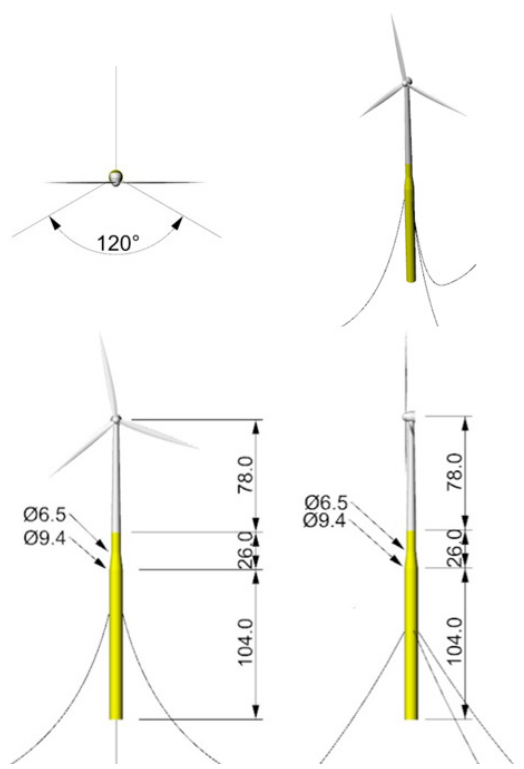
Figure 1. The schematic diagrams of the NREL 5MW wind turbine mounted on the OC3-Hywind or UMaine-Hywind spar with the catenary mooring system in different views. (Unit: m.) UMaine-Hywind spar with the catenary mooring system in different views. (Unit: